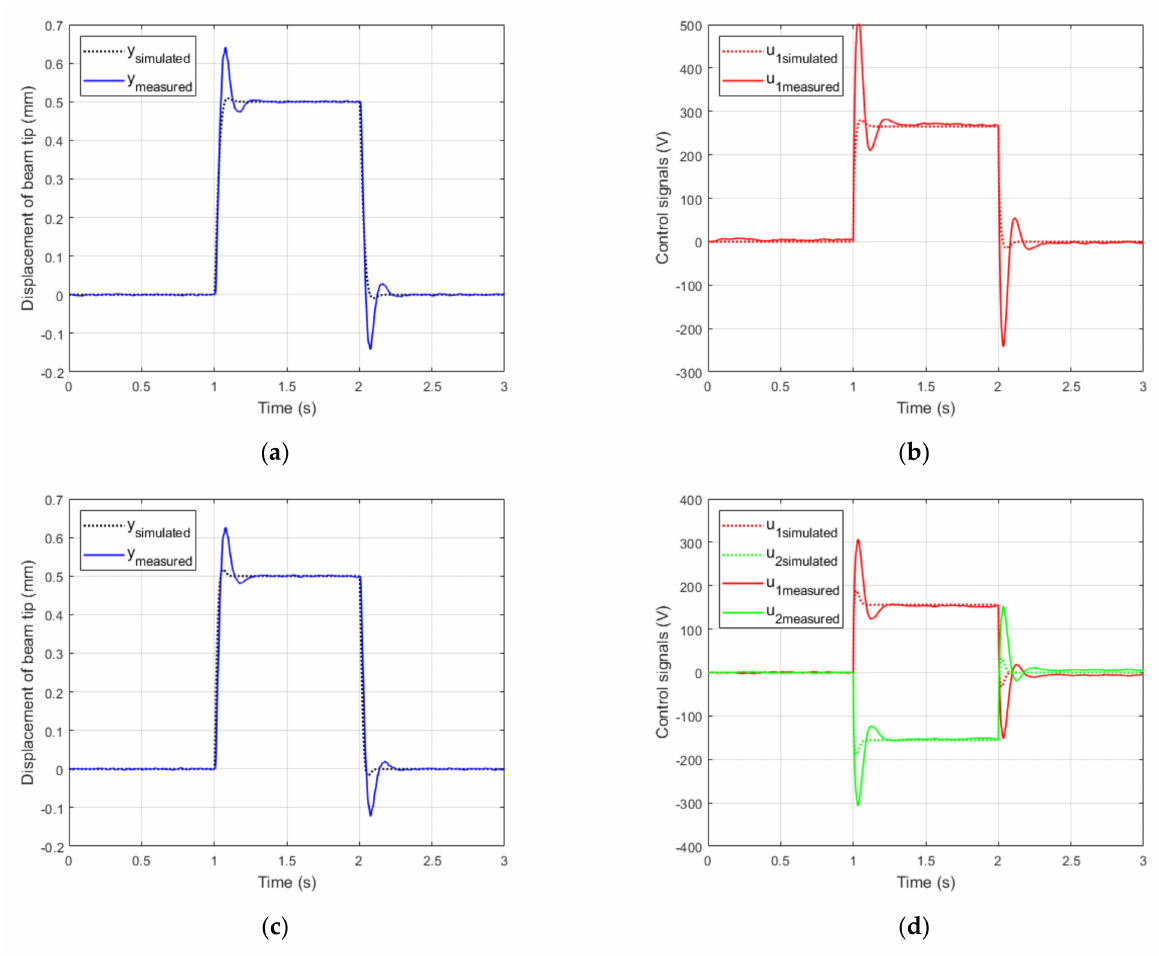
Figure 7. Control system characteristics for r 11 and r 22 equaled 1/150 2 : ( a ) Output for one-input; ( b ) Control signals for one-input; ( c ) Output for two-input; ( d ) Control signals for